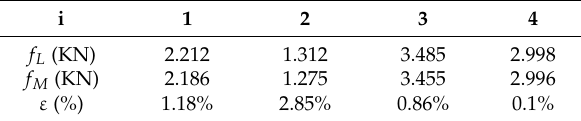
Table 5. Coupling degree of the branches.